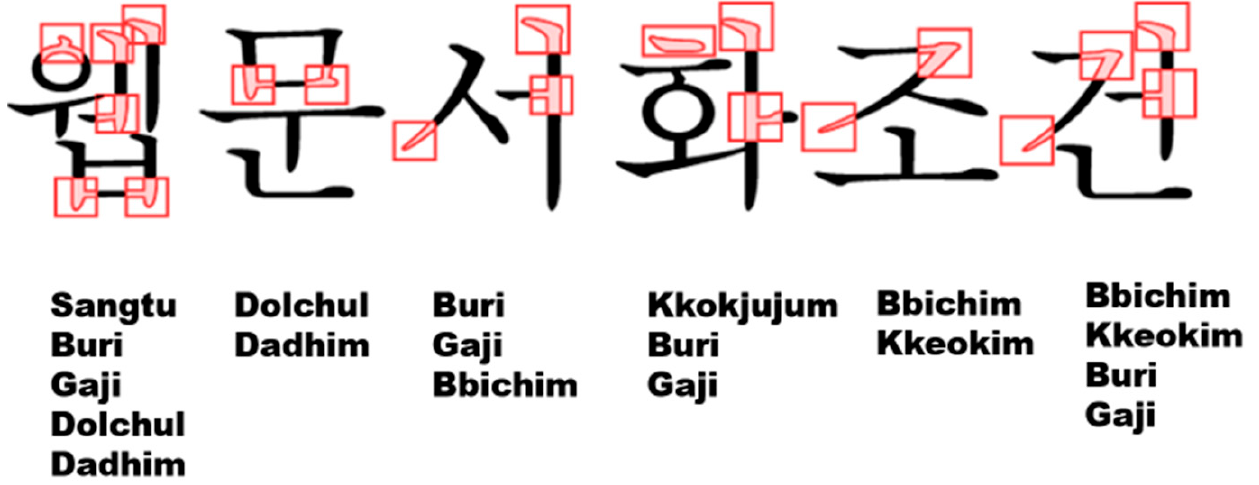
Figure 5. Representative Letter used in training object detection model. In the figure, the stroke elements of each Hangul letter are shown in red, and you can see the stroke elements that can be found in each letter. The above stroke elements are used for training the object detection model.